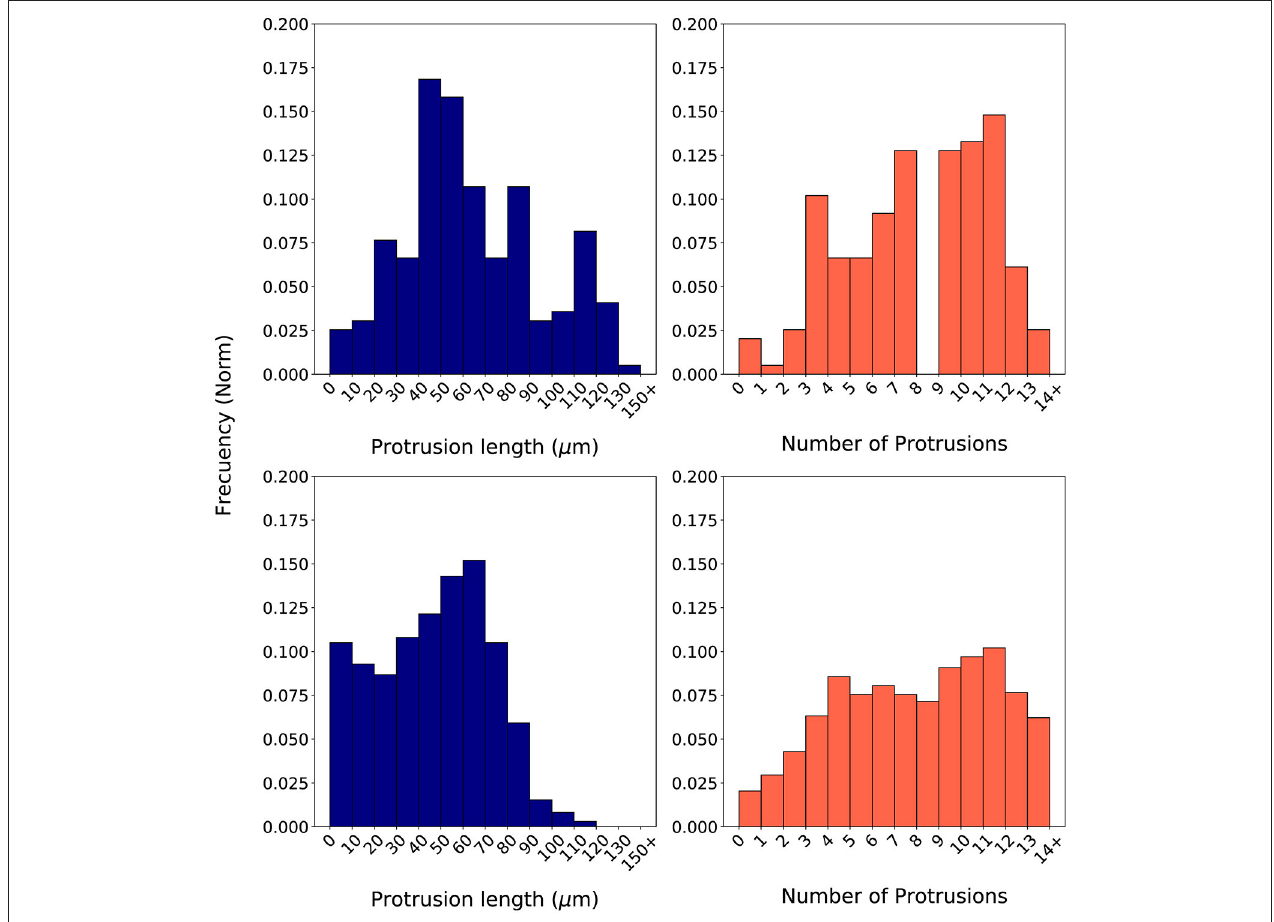
FIGURE 7 | Normalized histograms associated to in vitro experiments (Top) based on the length of the longest protrusion (measured in µ m) (Left) and on the number of protrusions (Right) . Normalized histograms associated to in silico experiments (Bottom) based on the length of the longest protrusion (measured in µ m) (Left) and on the number of protrusions (Right) . In silico experiments were generated using one of the best parametrizations suggested by SigOpt with metrics BC llp = 0.87 and BC np =